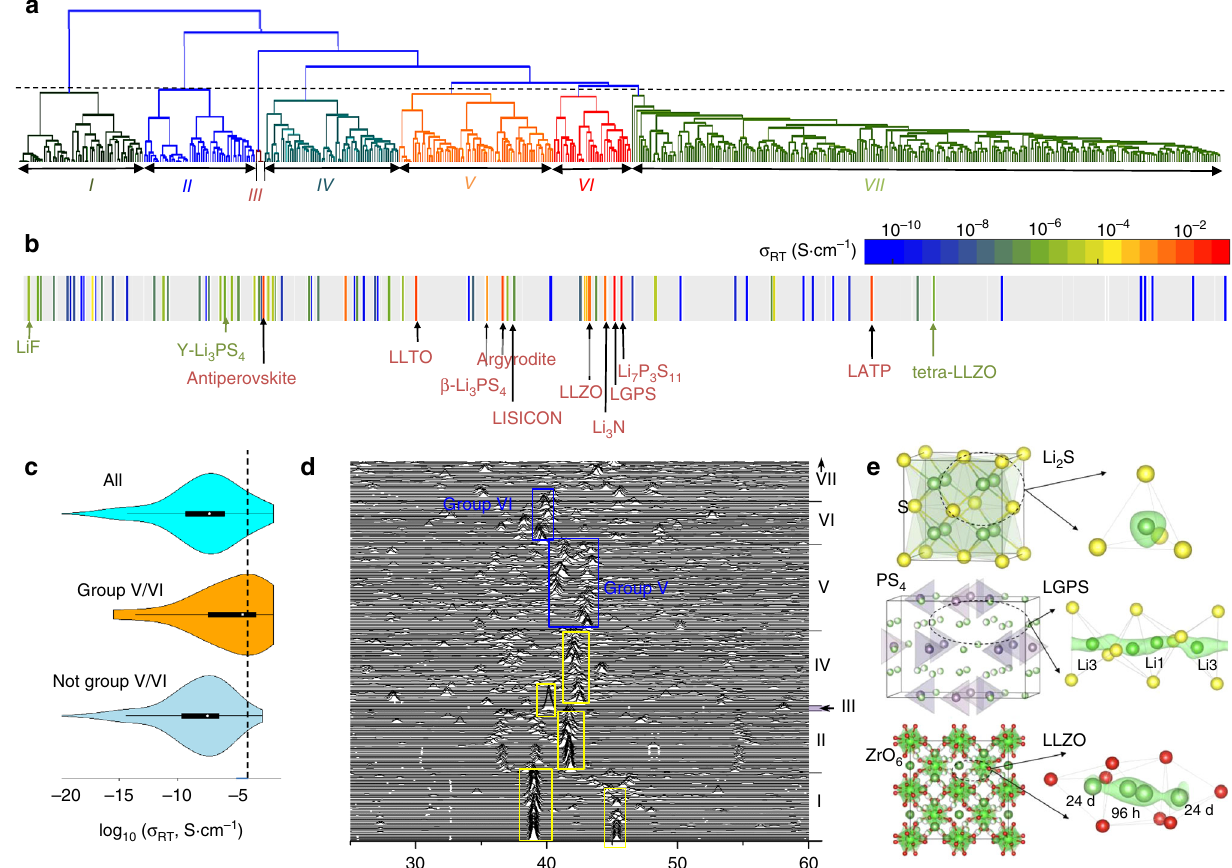
Fig. 2 Unsupervised clustering of all Li-containing compounds. a Bottom-up tree diagram (dendrogram) generated using the agglomerative hierarchical clustering method. The dashed line shows the position where all compounds are partitioned into seven groups, marked as I – VII from left to right and distinguished by different colors. b Mapping the dendrogram to the conductivity reveals the grouping of known solid-state Li-ion conductors in group V and VI. The color bar shows the scale of σ RT . The gray color indicates the conductivity has not been measured for the corresponding compound. c Violin plots of σ RT data grouped in the grouping. The outer shells of the violins bound all data, narrow horizontal lines bound 95% of the data, thick horizontal lines bound 50% of the data, and white dots represent medians. The dashed line shows the position of σ RT = 10 – 4 S cm − 1 . d mXRD of all materials in group I – VI and a part of group VII. The colored boxes mark the positions of main characteristic peaks for each group. e Crystal structures (left) and (right) Li sites (green sphere) determined by local anion (yellow/red sphere) con fi guration, corresponding to isosurfaces (green) of Li probability density from AIMD simulations. Li 2 S (top) with highly symmetric anion lattice and ordered Li sublattice versus LGPS (middle) and LLZO (bottom) SSLCs with distorted anion lattices and disordered Li